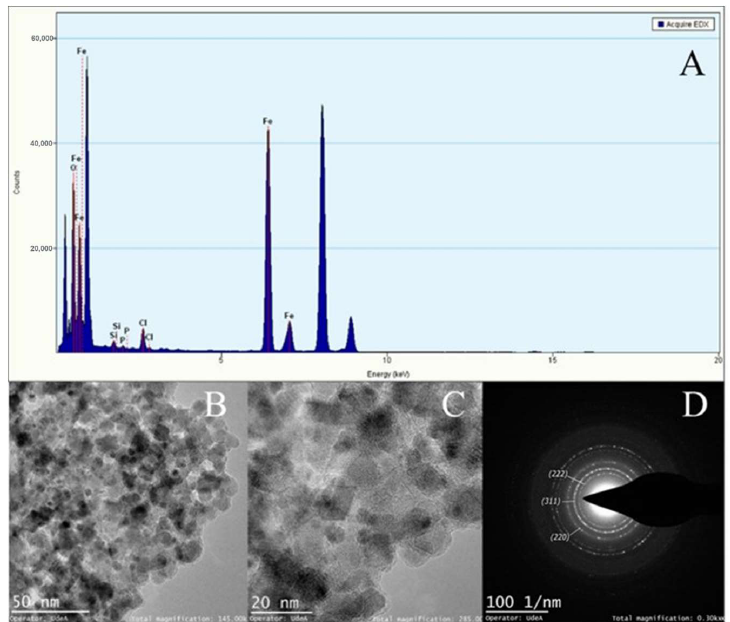
Figure 9. TEM−EDX analysis of magnetite particles manufactured by the SB micromixer ( A ). Ele- mental analysis confirmed the abundance of iron. ( B ) Low magnification imaging confirmed the typical morphology of magnetite crystals. ( C ) High magnification imaging allowed the calculation of an average particle diameter of 10.14 ± 2.8 nm. ( D ) Selected area electron diffraction with indexed planes that correspond to magnetite crystalline planes.